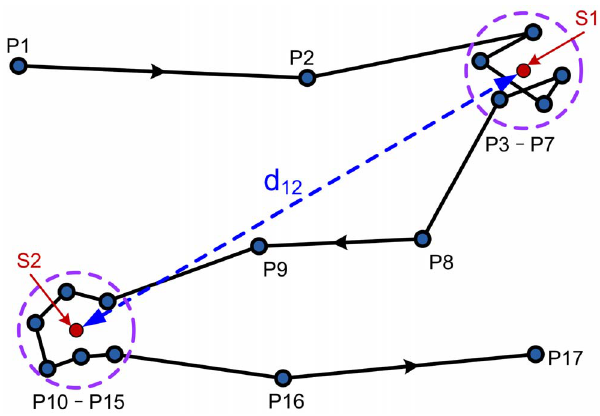
Figure 1. Illustration of the distinguishing on effective staying positions. P1–P17 represent 17 track points recorded by a GPS equipment from which we obtain two staying points S1 and S2. The displacement of travel is defined as the distance between the centers of the two staying points.